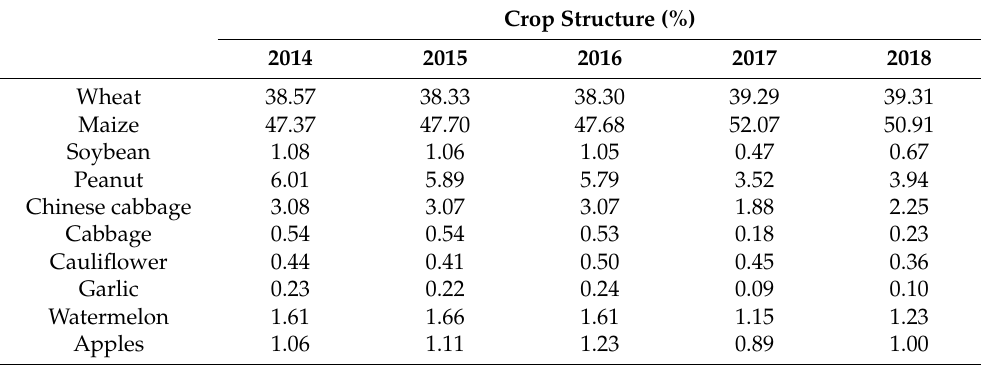
Table 6. Crop structure in